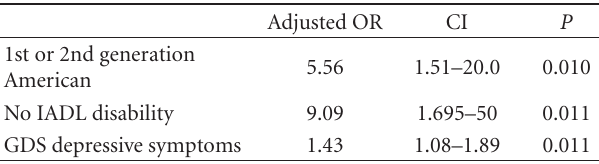
Table 3: Factors associated with older Mexican Americans’ positive attitudes toward Ventilator